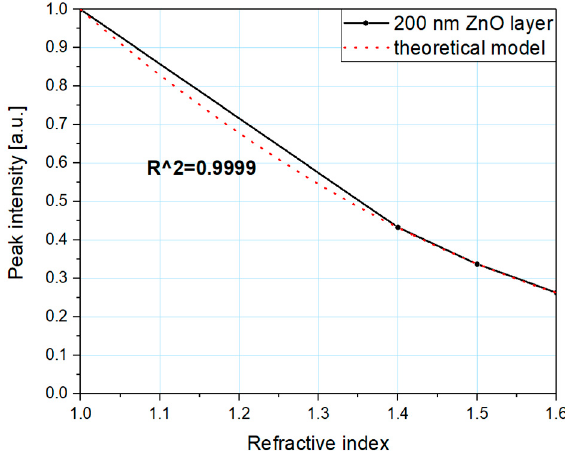
Figure 7. Measured response of the fiber-optic interferometer for a microsphere with ZnO layer.